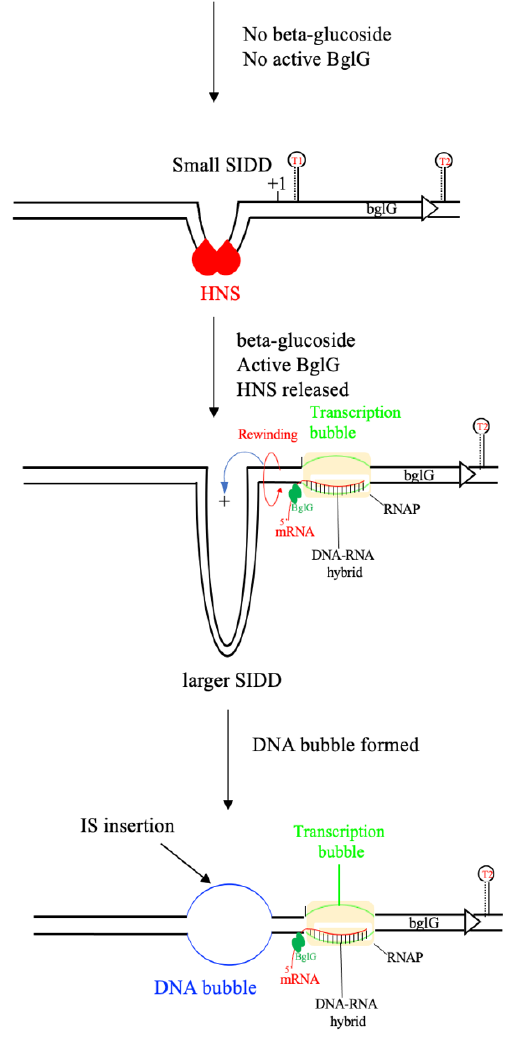
Figure 8. A proposed model for BglG-activated IS insertional Bgl + mutations. In the absence of β-glucoside, no BglG is produced, or if any is produced, BglG would be in the inactivated form. Meanwhile, H-NS binds tightly to the SIDD structure, thereby minimizing the SIDD ssDNA bubble size, blocking both transcription and IS insertion. Therefore, no Bgl+ mutations occur in the absence of a β-glucoside. In the presence of a β-glucoside, the residual BglG is activated and then binds to nascent mRNA that stabilizes the transcription bubble by forming a DNA-RNA hybrid. A stabilized transcription bubble and DNA rewinding lead to a conformational change of the upstream DNA, including the SIDD region, causing the (occasional) release of H-NS from the SIDD. Without H-NS binding, the SIDD structure becomes stronger and larger, and, therefore, it is easier to form a single-stranded DNA bubble. The presence of larger ssDNA bubbles facilitates the insertion of IS elements. In the presence of a β-glucoside, higher levels of activated BglG protein (such as in strains Ptet-G and Iq-G) result in more stabilized transcription bubbles and DNA rewinding, thereby producing one or more larger single-stranded DNA bubbles in the SIDD region, thus promoting IS insertion.